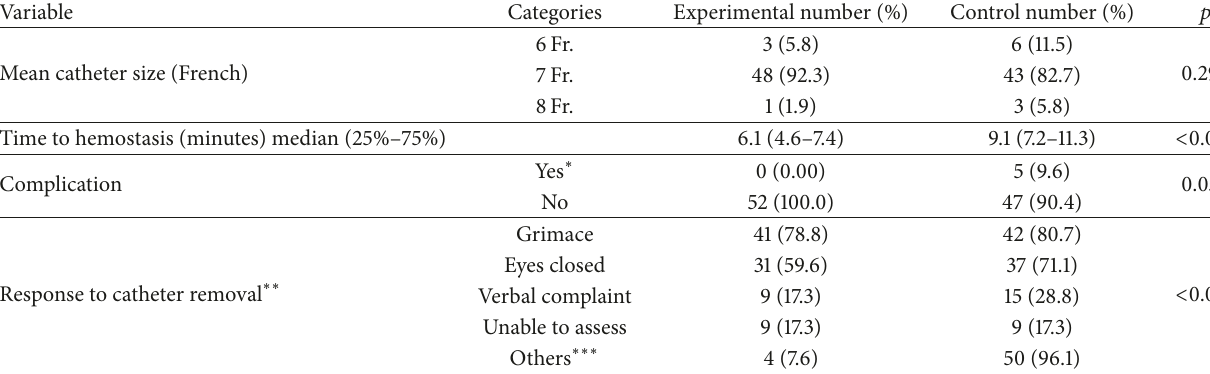
Table 3: Clinical characteristics of the experimental and control groups.